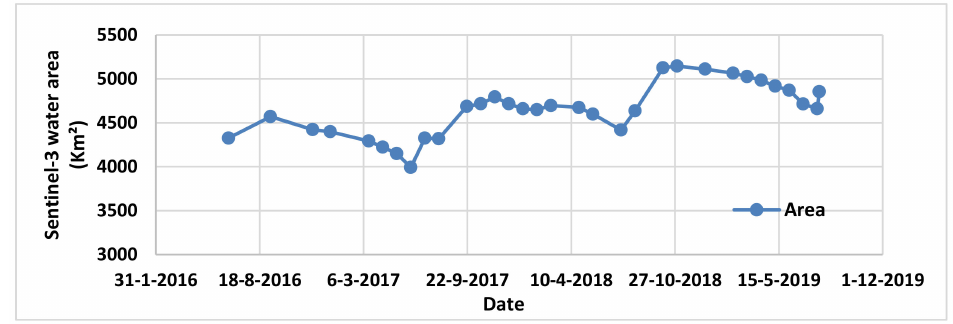
Figure 8. Water surface area variation with time series from 2016 to